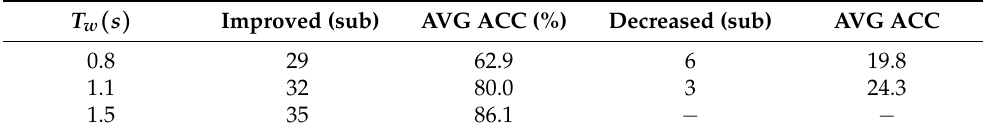
Table 3. Average accuracy of improved subjects and decreased